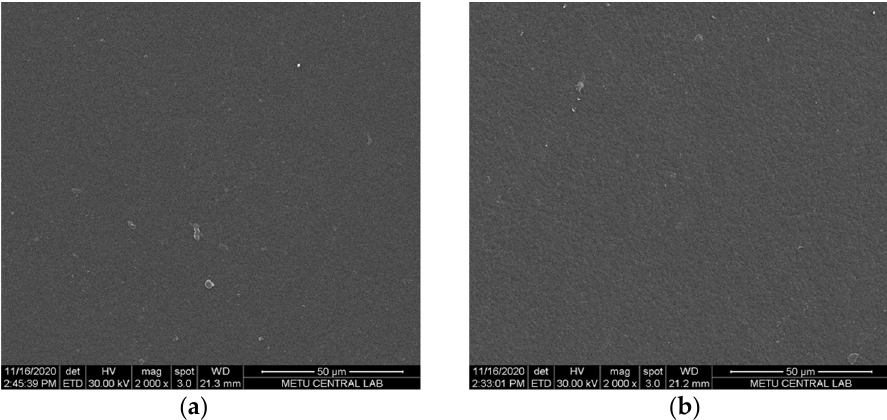
Figure 3. Surface morphology of ( a ) PECH-H and ( b ) PECH-C membranes (magnification: 2000×).